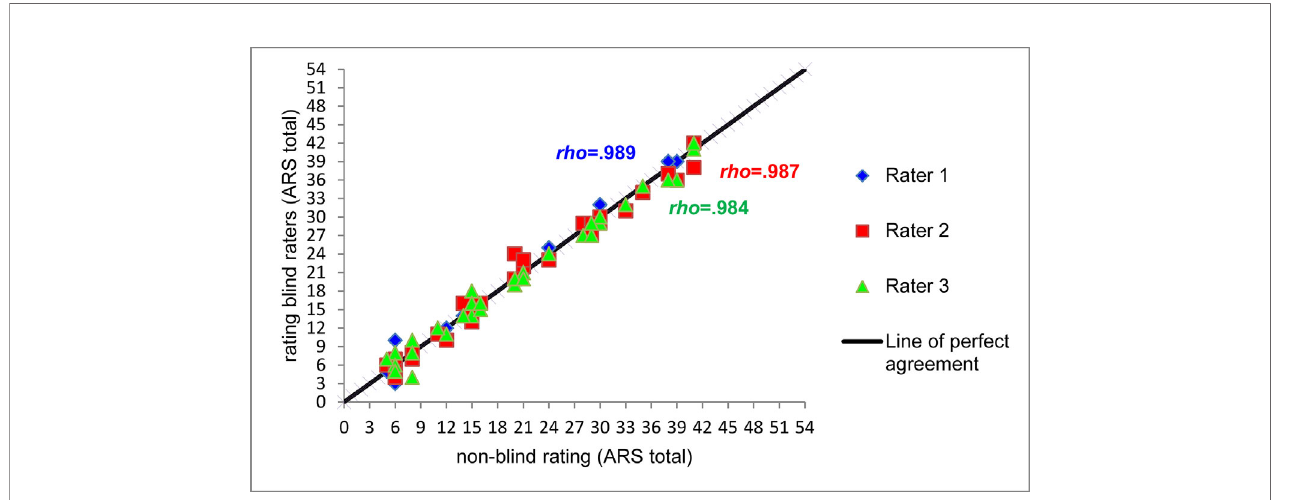
FIGURE 2 | Scatterplot and Spearman correlations between non-blinded ARS total rating and three blinded raters ( n = 33, Rater 1: rho (31) = .989, p < .001, Rater 2: rho (31) = .987, p < .001, Rater 3: rho (31) = .984, p <